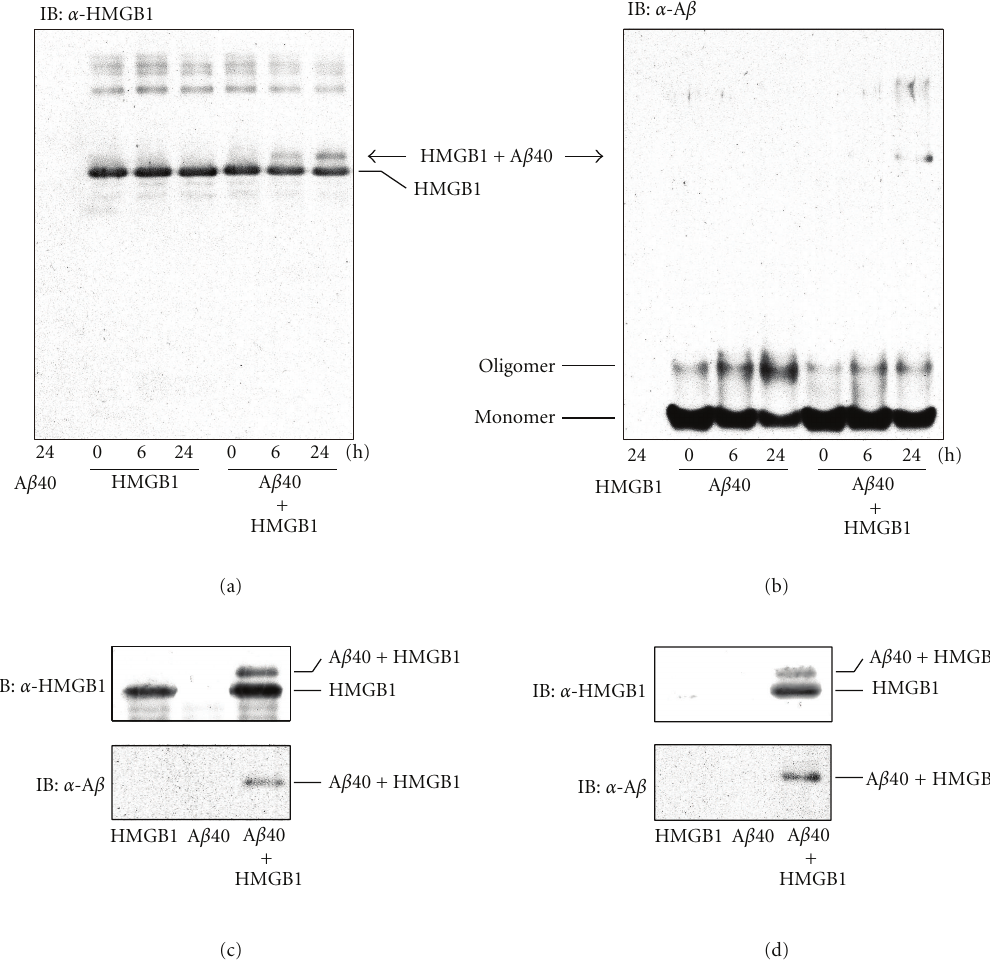
Figure 1: Binding a ffi nity of HMGB1 for A β 40. (a, b) After incubation of HMGB1, A β 40, and the mixture of HMGB1 with A β 40 for 0, 6, and 24h, samples were analyzed by Western blot analysis using the anti-HMGB1 antibody (a) or anti-A β antibody (b). (c, d) After incubation of HMGB1, A β 40, and the mixture of HMGB with A β 40 for 24 h, samples were immunoprecipitated using the anti-HMGB1 antibody (c) or anti-A β antibody (d). The precipitates were then analyzed by Western blot analysis using the anti-HMGB1 antibody and anti-A β